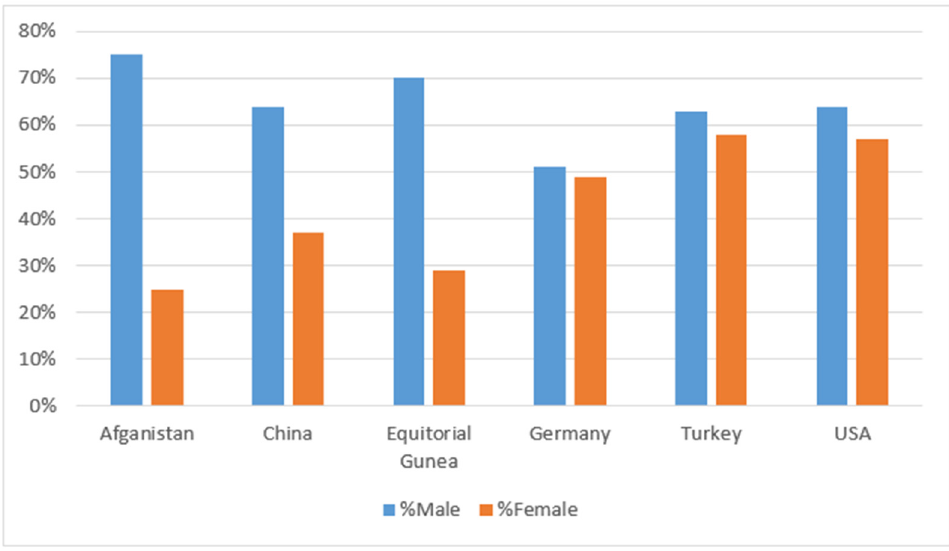
Figure 2. Cross-country COVID-19 infection, showing gender as a factor that can affect screening (El-Rashidy et al., 2022) .